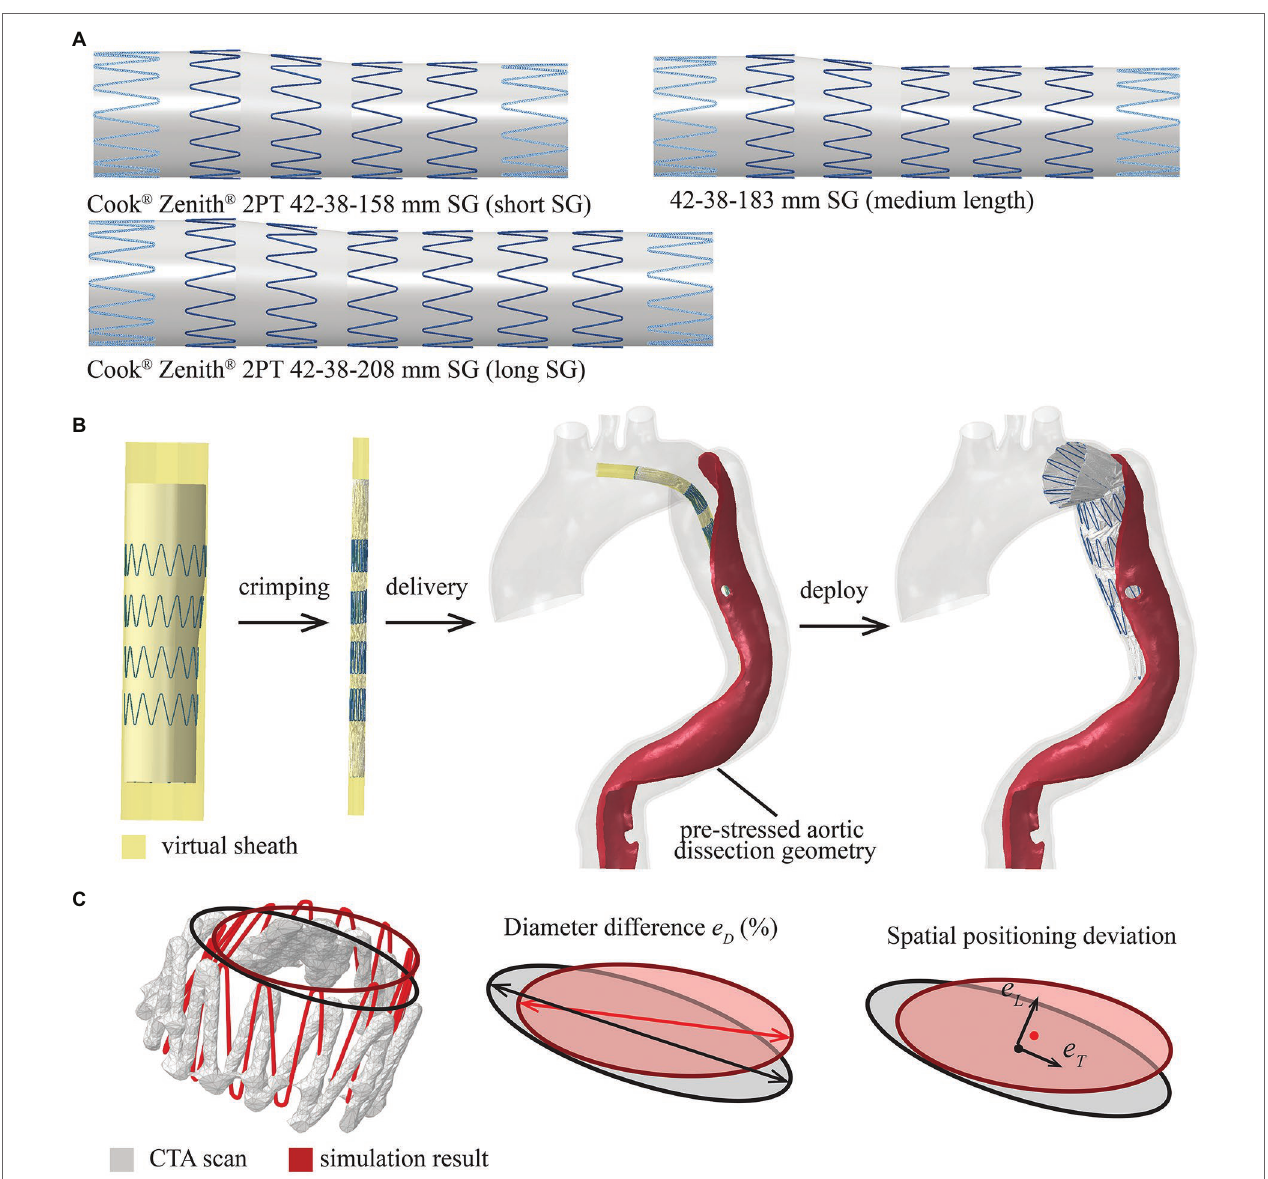
FIGURE 3 | Summary of the modelled stent-graft (SG) and FEM-based simulation workflow. (A) Cook Zenith 2PT tapered SG with different lengths (the proximal and distal strut are shown with dash line as they were sewed inside of the synthetic graft), (B) the SG was crimped, delivered and deployed by controlling the virtual sheath, and (C) definitions of parameters for quantitative assessment of SG configuration, diameter difference ( e D ), spatial positioning deviation in longitudinal direction ( e L ) and transverse direction ( e T